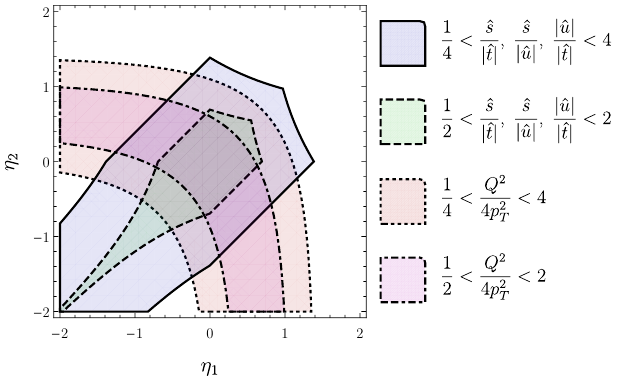
^ t ^ u : blue-solid ( j = 4) and green-dashed (cid:24) j j (cid:24) j j